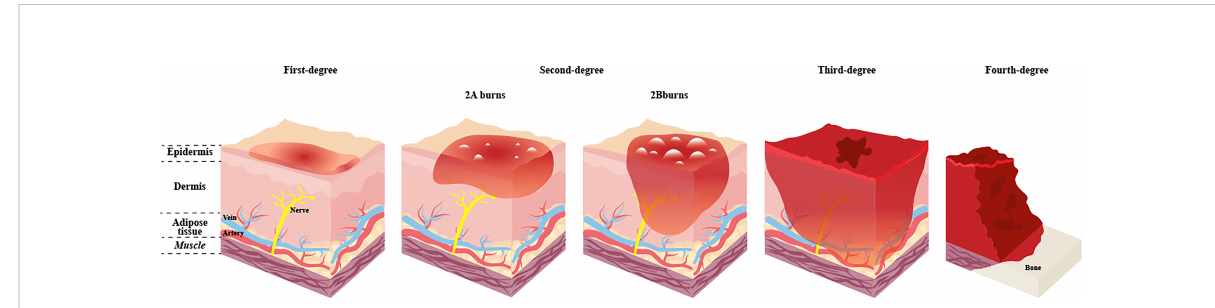
FIGURE 1 Categorization and depth of burn. The depth of the wound is signi fi cant for the categorization, treatment and prognosis of the burn. The deeper the burn, the more likely it is to operate and the more challenging it is to deal with postoperative scars. First-degree burns affect the epidermis only, with obvious pain, generally do not leave scars after healing, and no surgery is needed. Once the burns extend to the dermis, the injuries are classi fi ed as second-degree burns, blisters will form on the surface of the skin, and the pain is obvious, which can be divided into 2A burns and 2B burns. 2A burns do not require surgery and may leave scars. 2B burns require surgery and leave more scars. Third-degree burns affect the whole skin and subcutaneous adipose tissue. Fourth-degree burns involve damage to deep tissues such as muscles or bones, and defects and blackening are often seen at the burn site. Third-degree and fourth-degree burns have no signi fi cant pain due to damage to nerve endings and have a high risk of infection. Both need